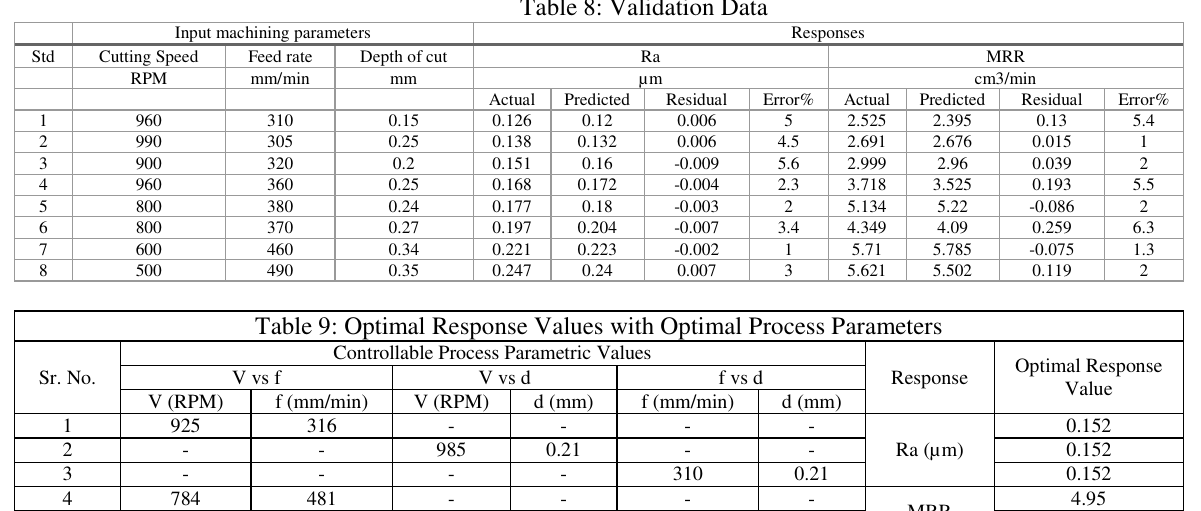
Table 8: Validation Data